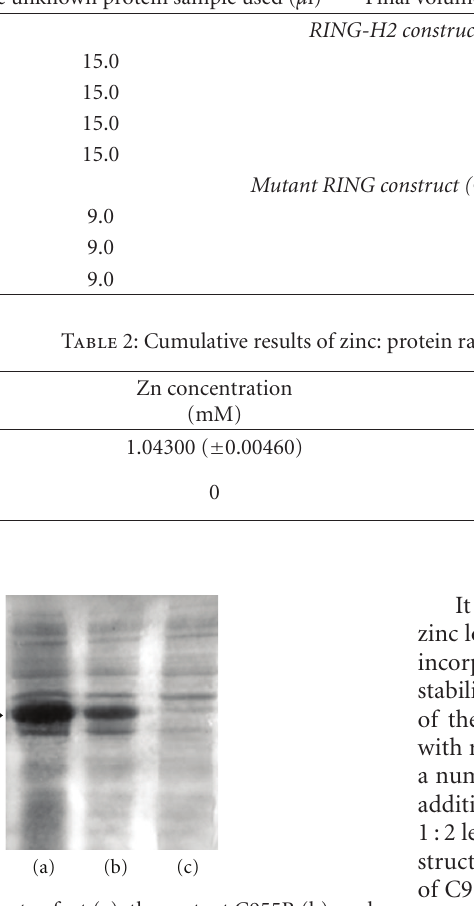
Figure 2: The total cell lysate of wt (a), the mutant C955R (b), and H960R (c) at 37 ◦ C with ZnCl 2 at a final concentration 100 μ